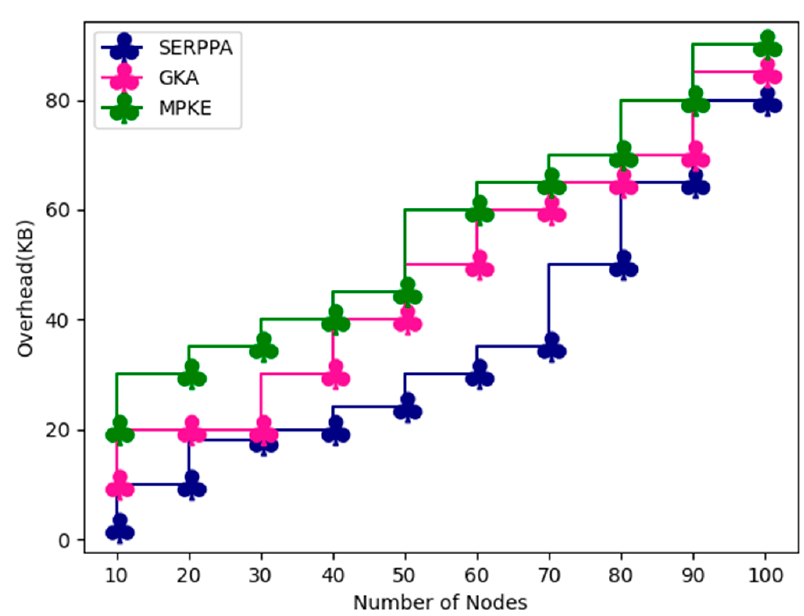
Figure 5. Overhead vs. number of nodes.